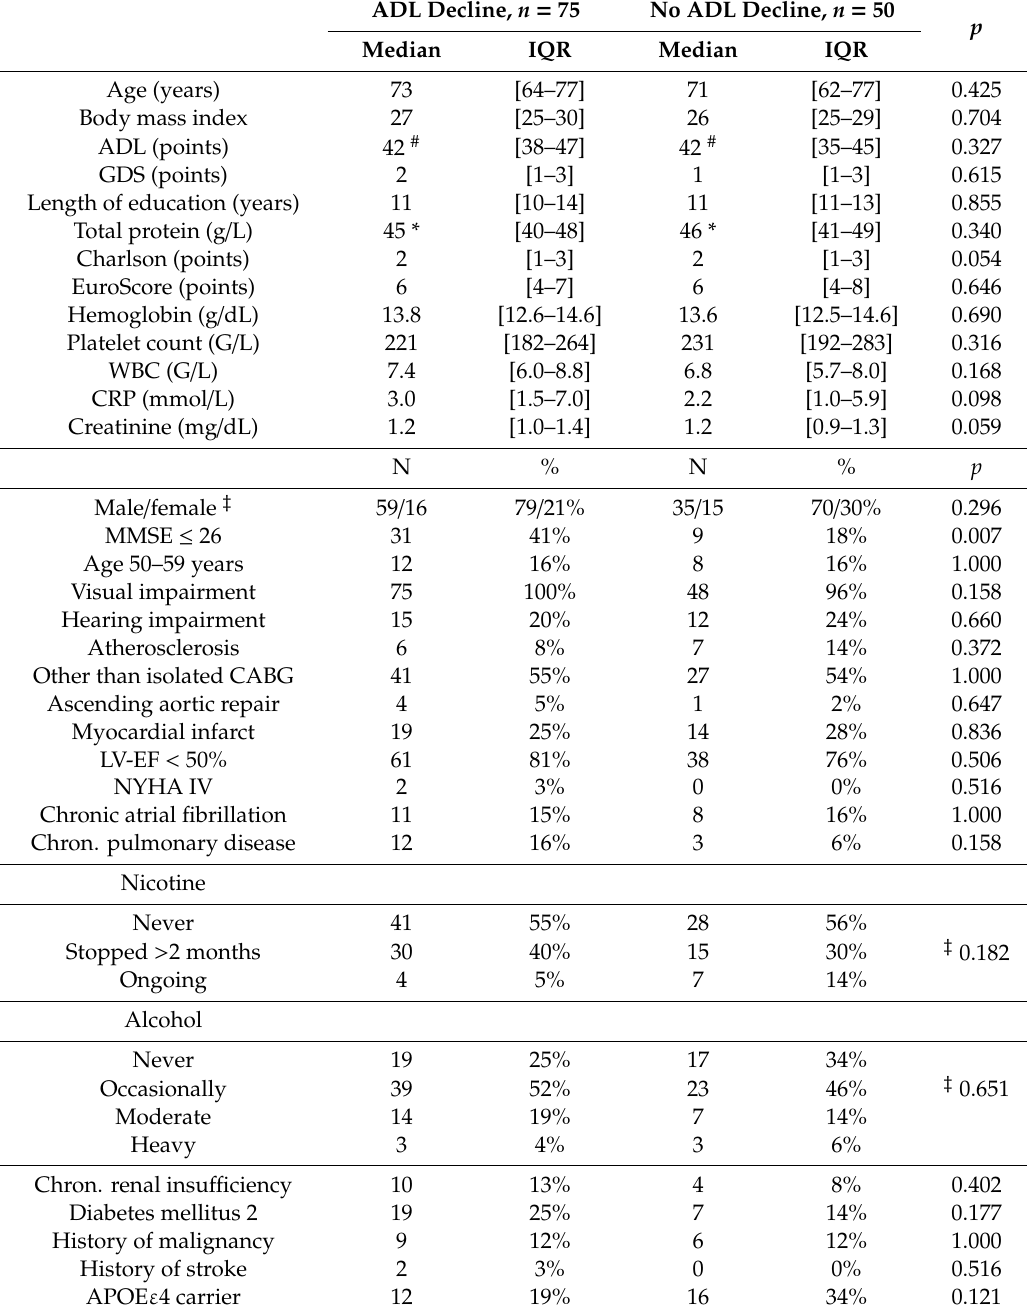
Table 1. Patients’